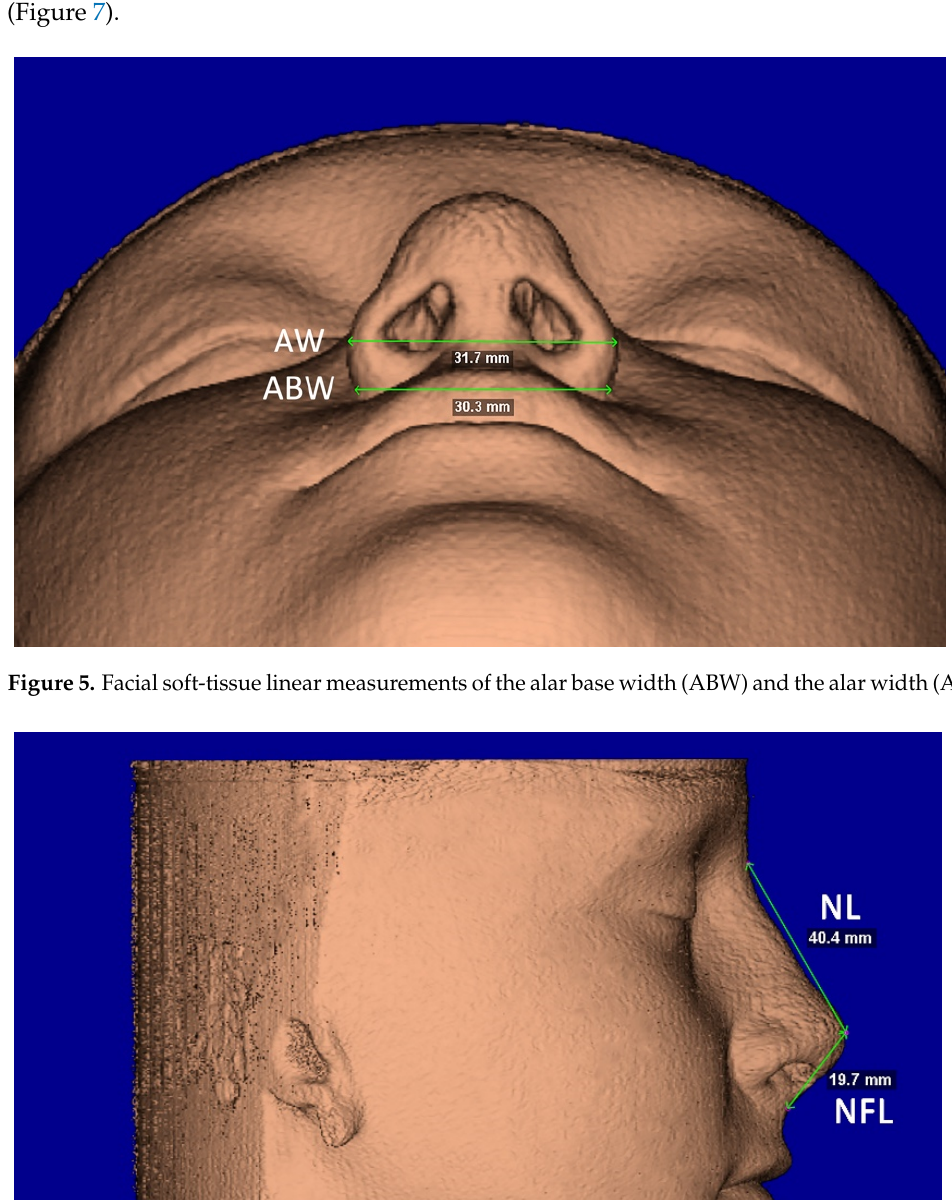
Figure 7. Facial soft-tissue linear measurement of the naso-labial angle (NLA). 2.6. Statistical Analysis 2.6.1. Sample Size Calculation In the absence of reference data from the literature, calculation of sample size power was preliminary carried out on 20 subjects (10 in the TB group and 10 in the BB group) using the following settings: primary outcome = measurements of ABW parameter, beta error = 0.20, alpha error = 0.05, comparison = difference in the T0-T1 changes of ABW in the TB group, software = SPSS ® version 24 Statistics software (IBM Corporation, 1 New Orchard Road, Armonk, New York, NY, USA). The difference detected in the ABW pa- rameter between T0 and T1 was 0.92 mm (SD = 0.88), and the analysis indicated that 28 patients were required to reach 80% power to detect the same difference. However,